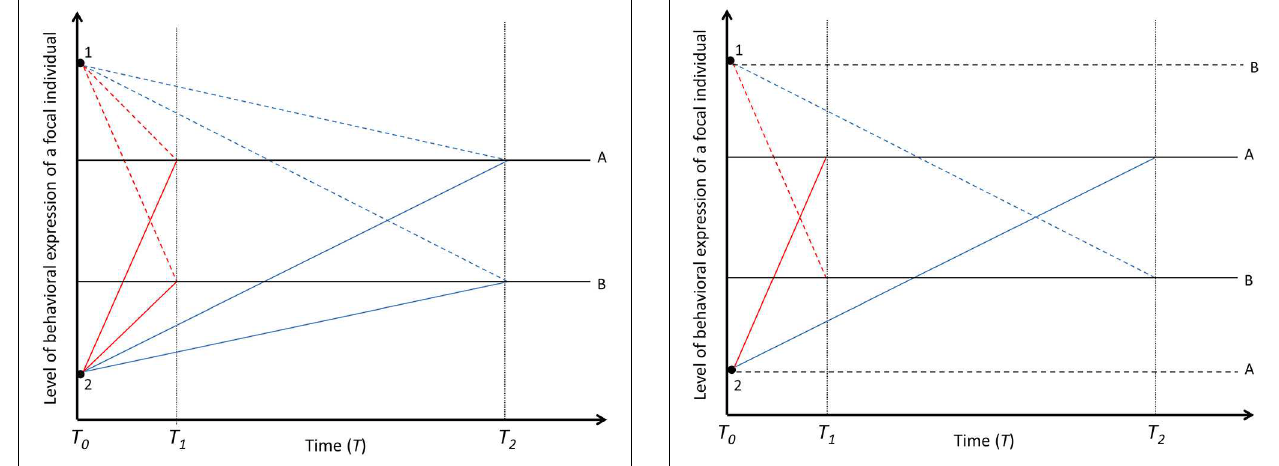
FIGURE 3 | Decay of within-individual variation in time. Solid black lines (A and B) represent two focal individuals with different mean baseline levels of behavioral expression. Colored lines represent the behavioral expression of the two focal individuals (A and B) under the influence of two different social partners (not at the same time) [Black dots; dashed lines for the effect of partner 1 and solid lines for the effect of partner 2, underpinned by fast-changing (red lines, decayed in T 1 ) or slow-changing (blue lines, decayed in T 2 ) state in focal individuals]. If social carry-over effects are underpinned by fast-changing states, the social partner (1 and 2) explains within-individual variation in the behavior of the focal individuals only over short temporal scales. If social carry-over effects are underpinned by slow-changing states, the social partners explain within-individual variation in the behaviors of the focal individuals over long temporal scales. The social interaction is terminated in T 0 . While we acknowledge that among-individual variation for phenotypic plasticity exist ( Nussey et al., 2007), for simplicity, the partner effects are assumed to be the same magnitude in T 0 for both focal individuals and for the fast- and slow-changing states.